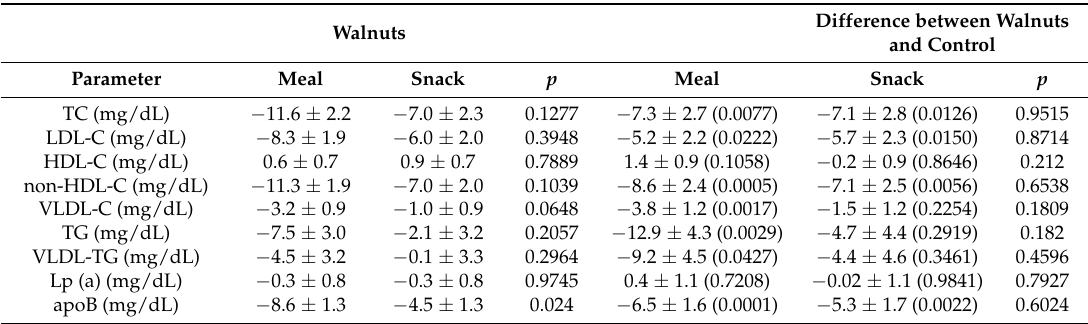
Table 4. Effect of walnut consumption on fasting lipids, apoB, and Lp (a) when walnuts were consumed with meals or as snack. Walnuts